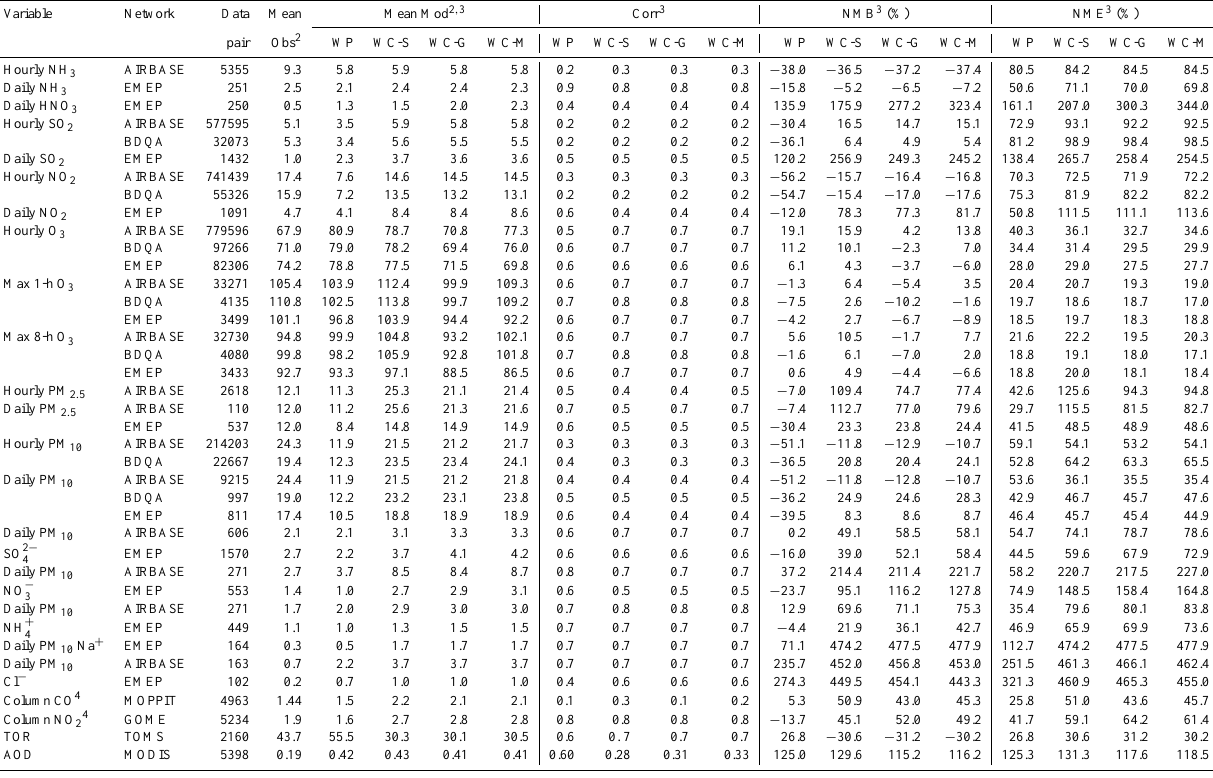
Table 1. Comparison of performance statistics of WRF/Polyphemus and WRF/Chem-MADRID over D01 1 .